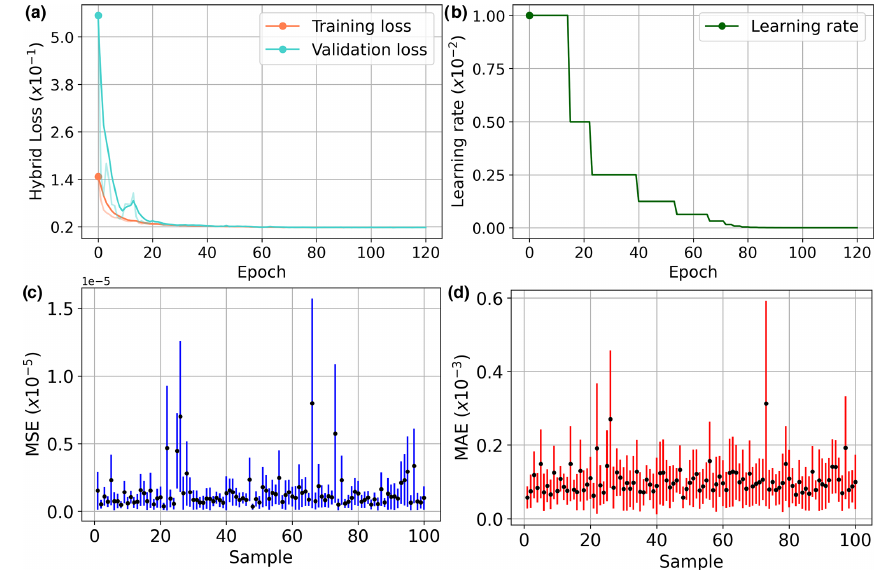
Figure 6. Training (cyan) and validation (orange) curves of using our developed hybrid loss (a) and the adaptive adjustment of the learning rate during the training (b) . We run the trained CNN 20 times to compute the MSE (c) and MAE (d) for the 100 models randomly chosen from the validation dataset in which the input structural data are regenerated in each computation. The black dot represents the average error, while the blue and red lines indicate the error ranges of the MSE and MAE, respectively.